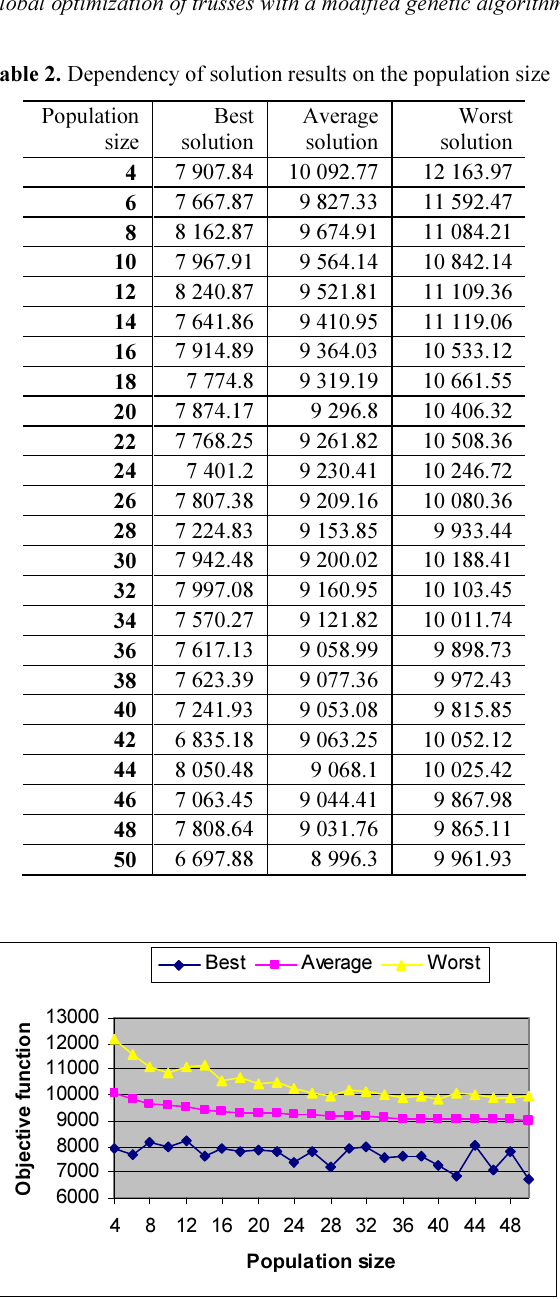
Fig. 8. The dependency of the solution results on the population